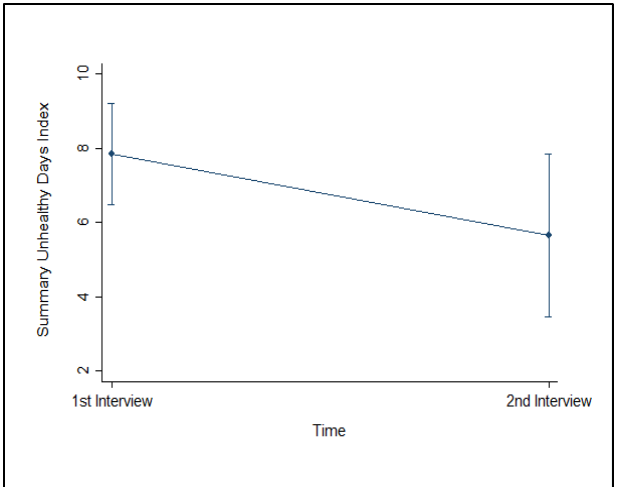
Figure 2. Summary Index of Unhealthy Days, (mean) over time.